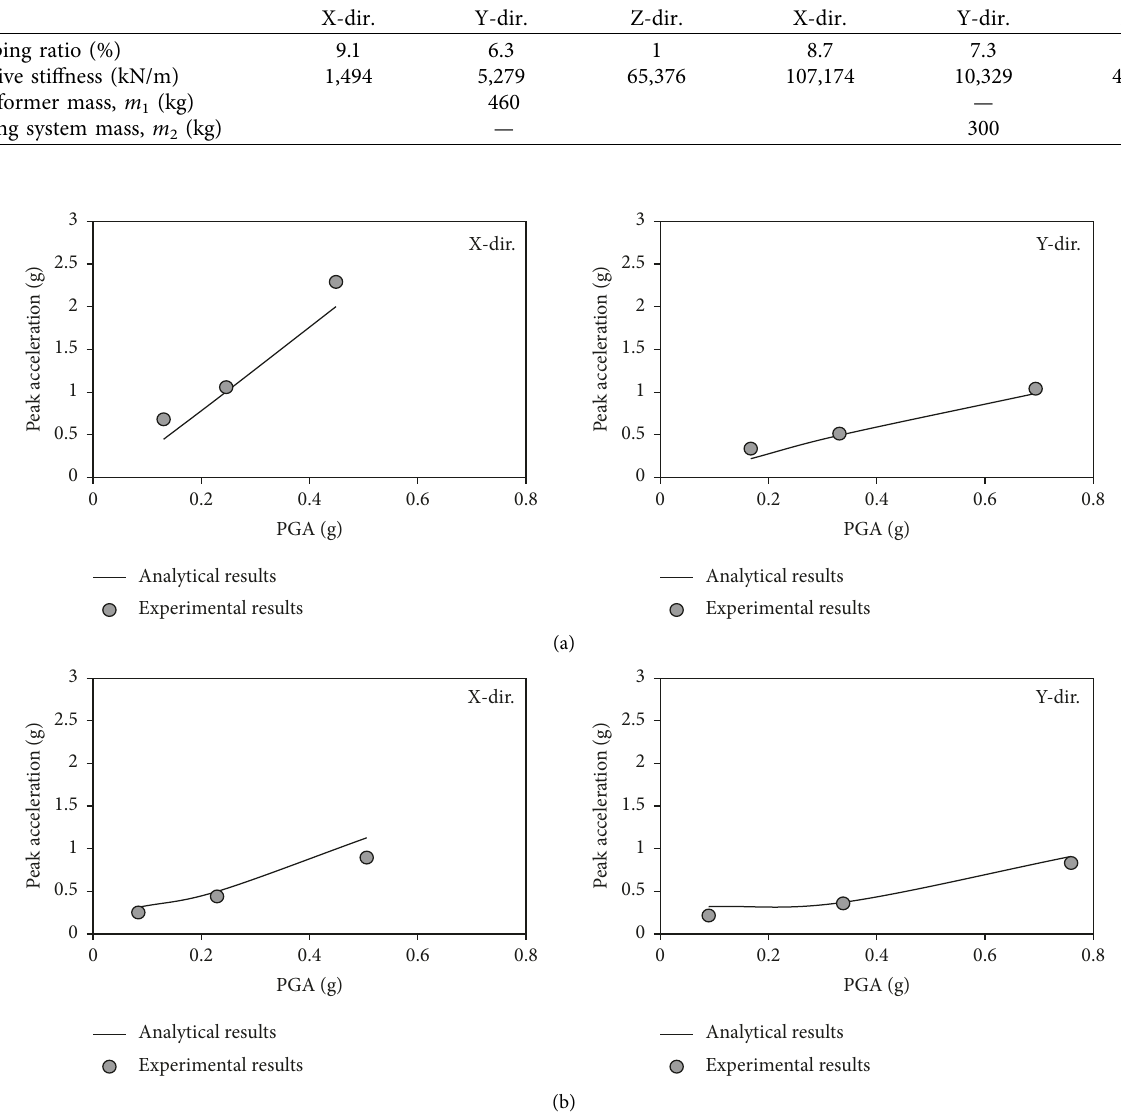
Figure 19: Peak acceleration versus PGA at the cooling system of the UPS specimens, as obtained from the experimental and analytical results. (a) Series A. (b) Series